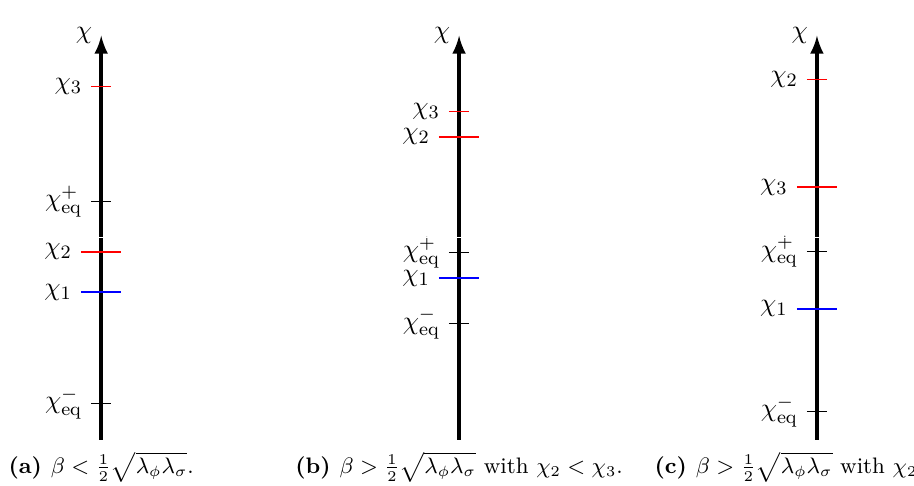
Figure 4 . The constraints on χ for three different illustrative cases. Here, we have defined χ 1 = , χ = βη 2 and χ is the additional constraint that is not yet understood. Lower γ − 1 λ σ η 2 − 1 λ σ η 2 2 3 σ σ φ 2 2